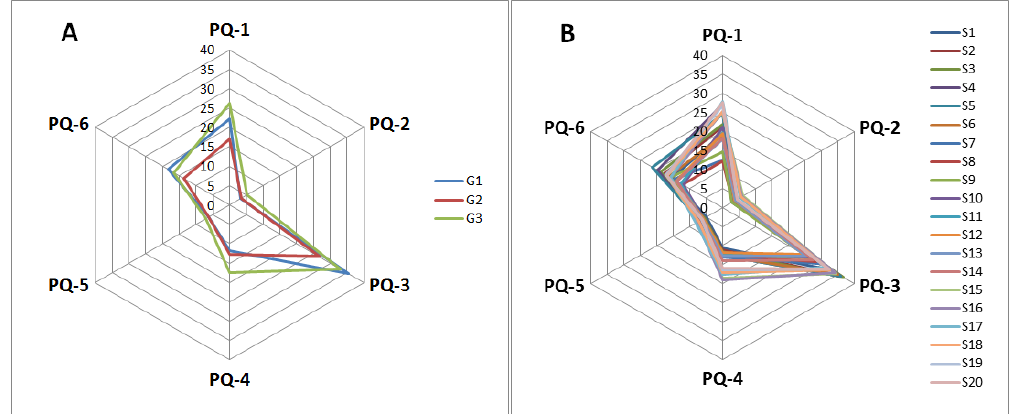
Figure 3. Radar plots showing the difference of geographical origins in terms of six components in various KMI samples; ( A ) G1, G2, and G3. ( B ) The distribution of the chemical composition of 20 KMI